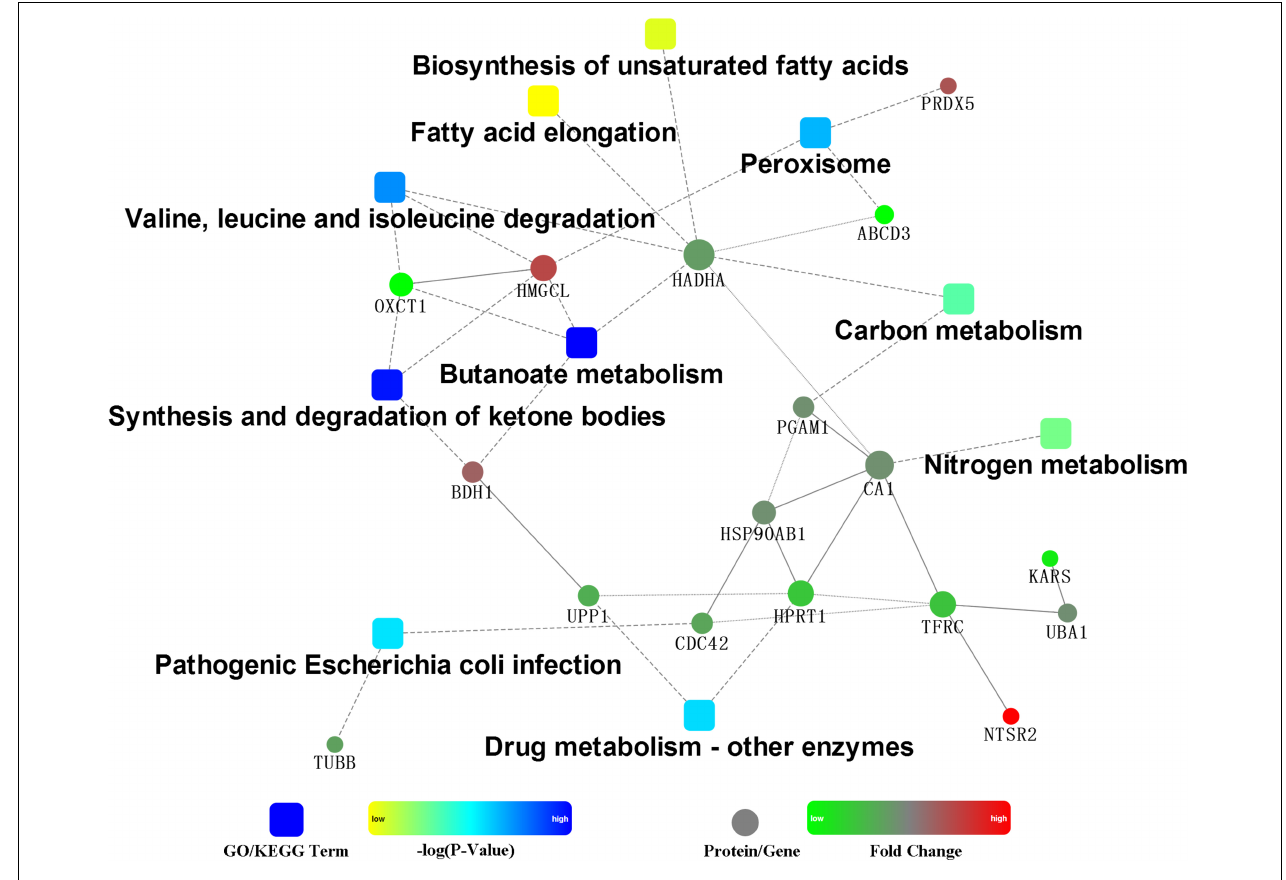
FIGURE 3 | Protein–protein interaction analysis by the